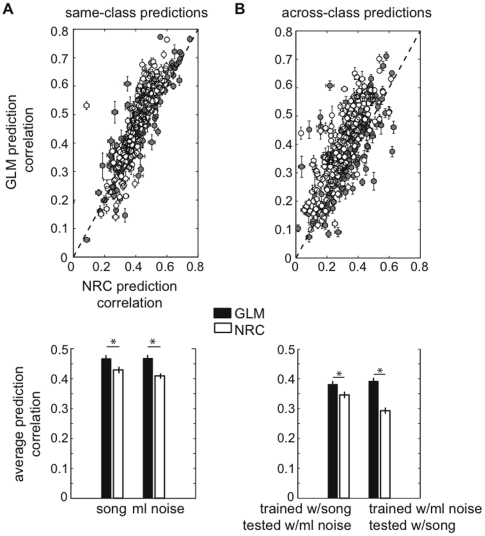
The GLM has higher predictive power than does NRC within- and across stimulus classes.Both methods were evaluated by their ability to predict responses to a validation song and ml noise data set that was not used for parameters' estimation. (A) Same-class predictions: NRC and GLM were used to predict responses to a novel song or ml noise stimulus when only songs or ml noise were used to train the model. (B) Across-class predictions: NRC and GLM were used to predict responses to a novel song or ml noise stimulus when the other stimulus ensemble was used to train the model. Each point plots the correlation coefficient between the observed and predicted average response (PSTH), for NRC (horizontal axis) and GLM (vertical axis) for a single neuron. White dots indicate responses to ml noise and gray dots indicate responses to song. We found that on average, the GLM predicts responses significantly better than NRC (*p<0.001, two-sample KS test) both in the same-class and across-class cases. Error bars represent SEs.